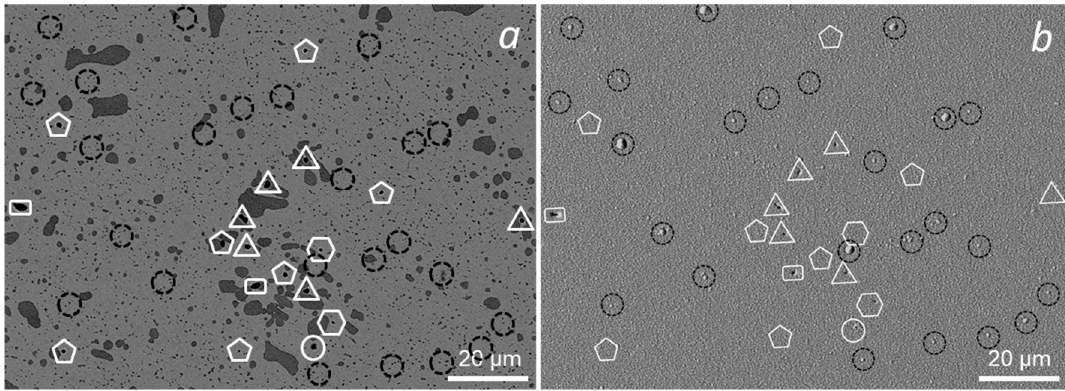
Figure 1. Scanning electron microscopy (SEM) images of D2 tool steel substrate after intensive (booster) and middle frequency (MF) ion etching ( a ) and the same surface area after sputter deposition of nanolayer nl-TiAlN/CrN hard coating ( b ). The sulfide, oxide, and other inclusions are marked with triangles, pentagons, and hexagons, respectively. Pits are designated with rectangles while sites where all other growth defects formed during the deposition process are labeled with black circles. Table 1. Surface densities of the non-metallic inclusions in D2 and ASP30 PM tool steel substrates. Oxide Inclusions Sulfide Inclusions All Inclusions